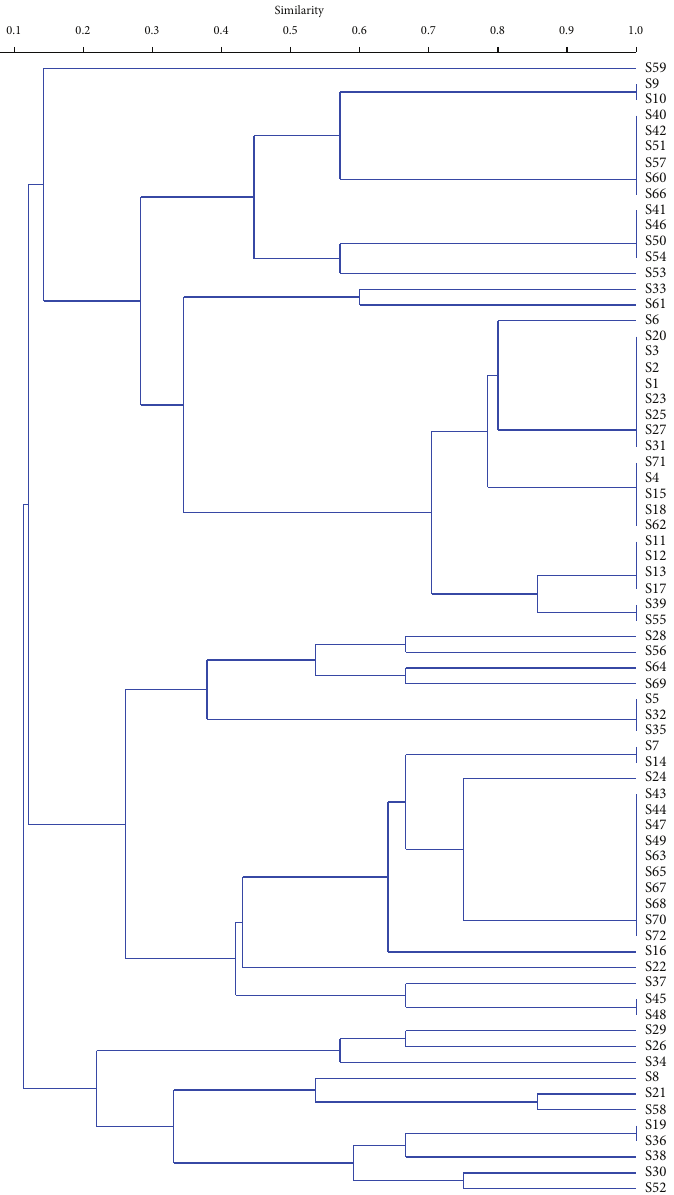
Figure 2: UPGMA dendrogram generated by cluster analysis of interdelta region patterns obtained from the Saccharomyces cerevisiae strains isolated during the later stages of spontaneous fermentation of Susumaniello grapes. Calculated percentages of similarity are given on the